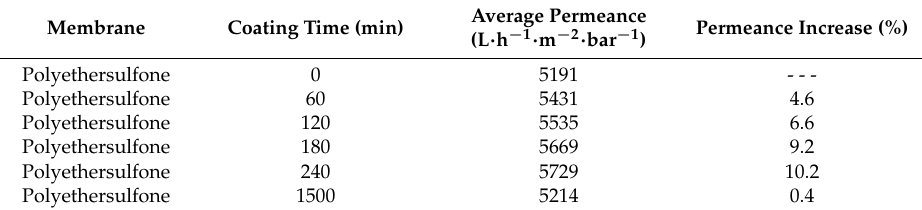
Table 2. Permeance increase of polyethersulfone membranes after polydopamine coating.